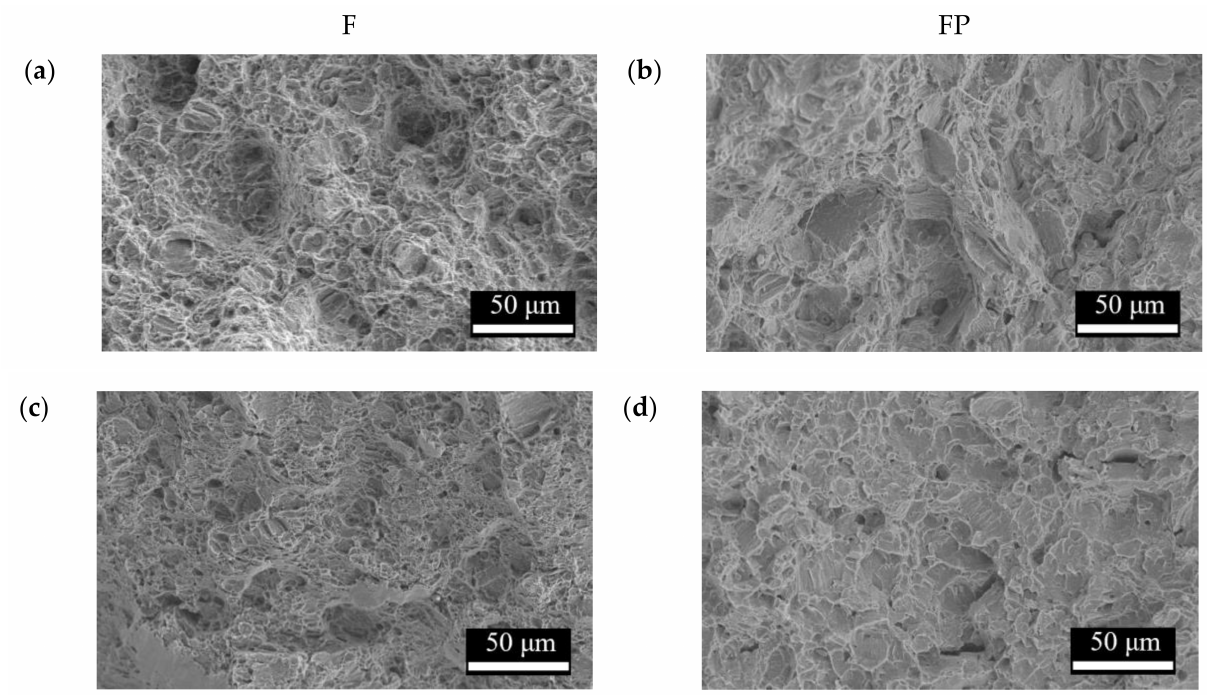
Figure 16. Tensile fracture surface morphologies of ( a ) F, ( b ) FP, ( c ) F-d28, and ( d )